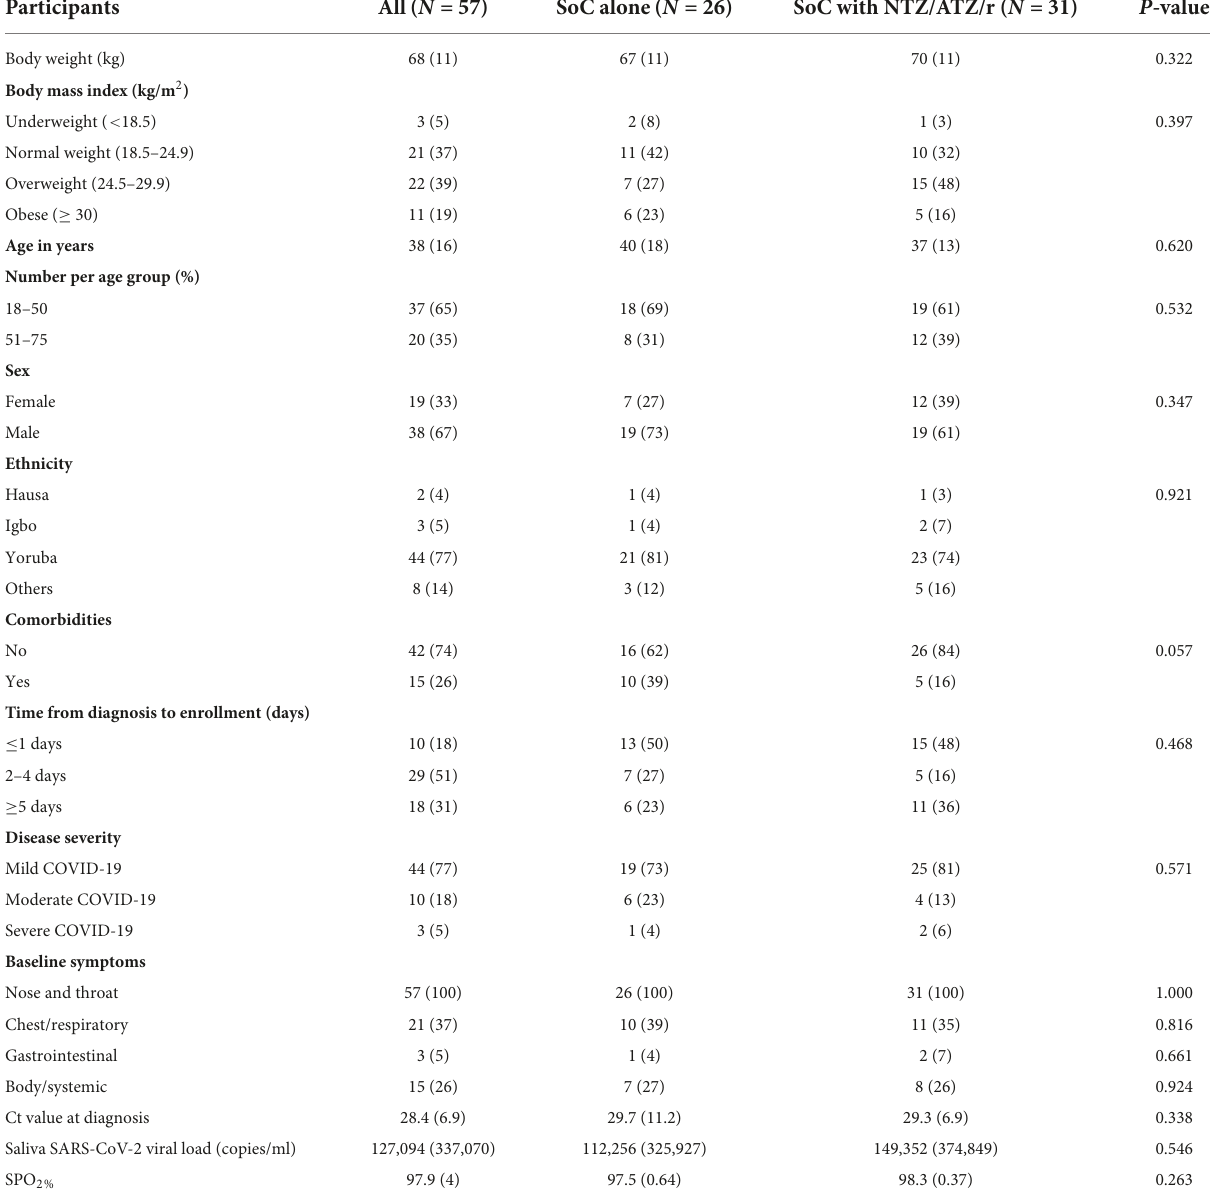
TABLE 1 Baseline characteristics of NACOVID trial participants at